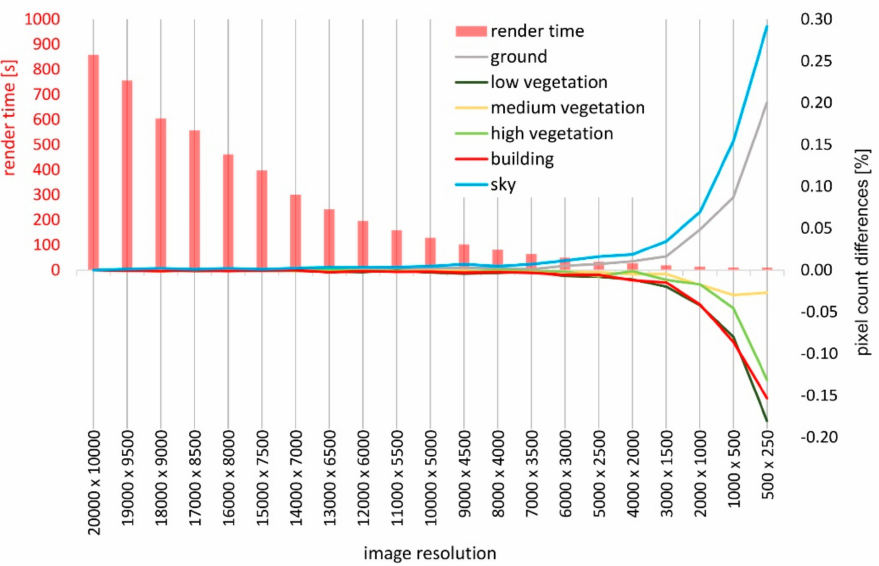
Figure 3. The influence of image resolution on the results of analysis against the rendering